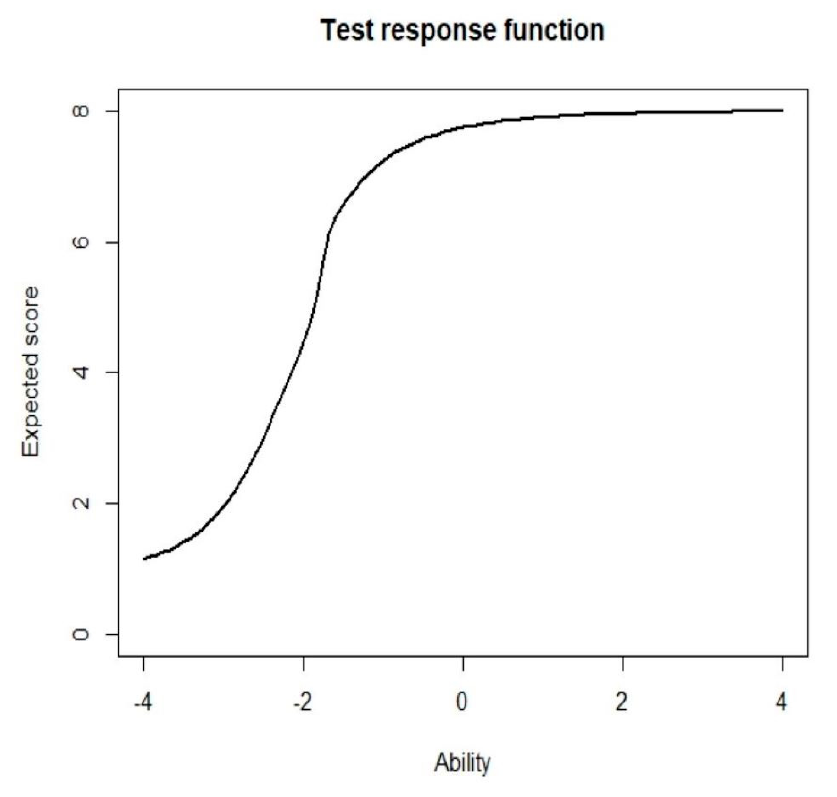
Figure 3. Test- response function of the test.